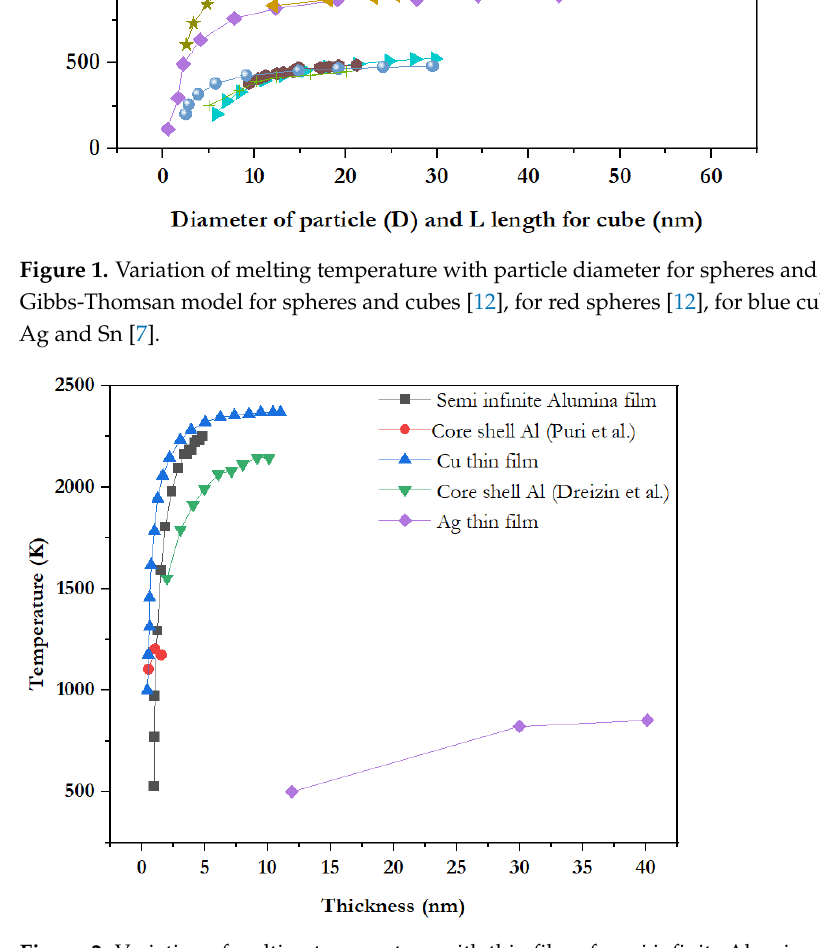
Figure 2. Variation of melting temperature with thin film of semi infinite Alumina film [12], core shell Al [17,18], Cu film [14], Ag film [19].